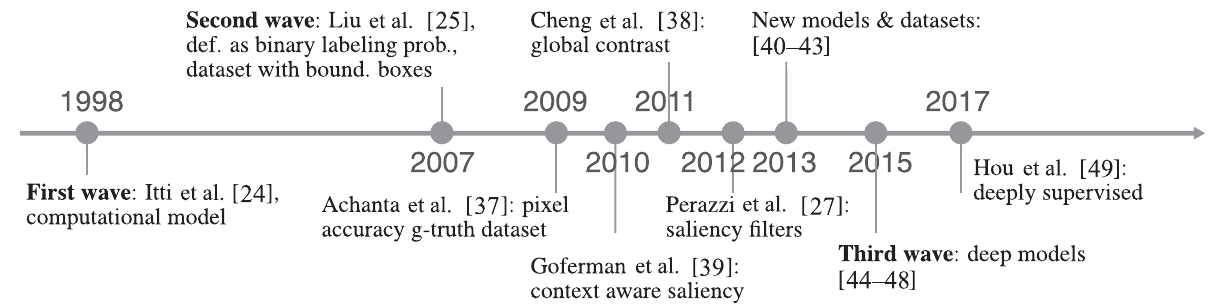
Fig. 3 A simplified chronicle of salient object detection modeling. The first wave started with the Itti et al. model [24], followed by the second wave with the introduction of the approach of Liu et al. [25] who were the first to define saliency as a binary segmentation problem. The third wave started with the surge of deep learning models and the model of Li and Yu